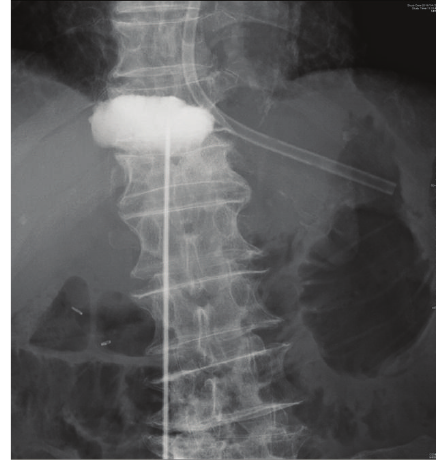
Figure 3: Percutaneous drainage was performed 3 days after perforation. Pale yellow ascitic fluid was drained. The result of peritoneal lavage cytology was